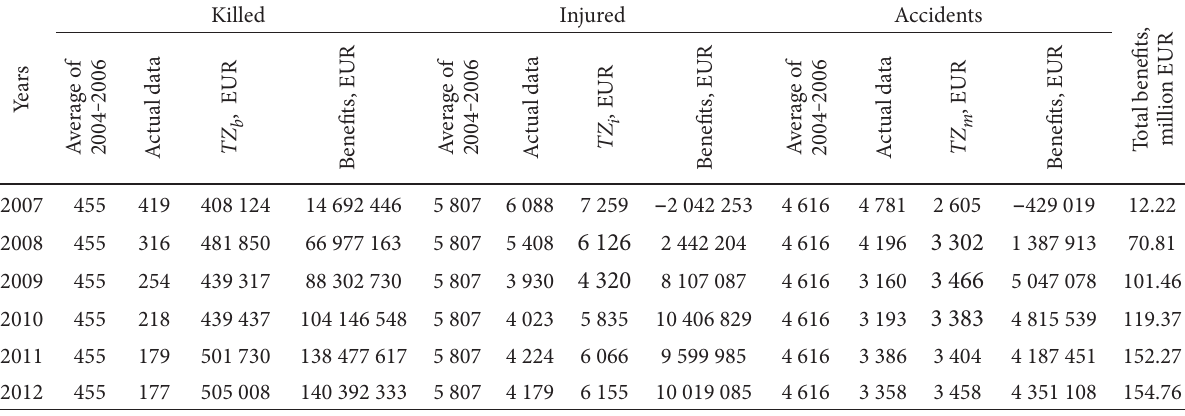
Table 2. Benefits of the implementation of the Road Traffic Safety Programme 2007–2013 Killed Injured s a r Y e